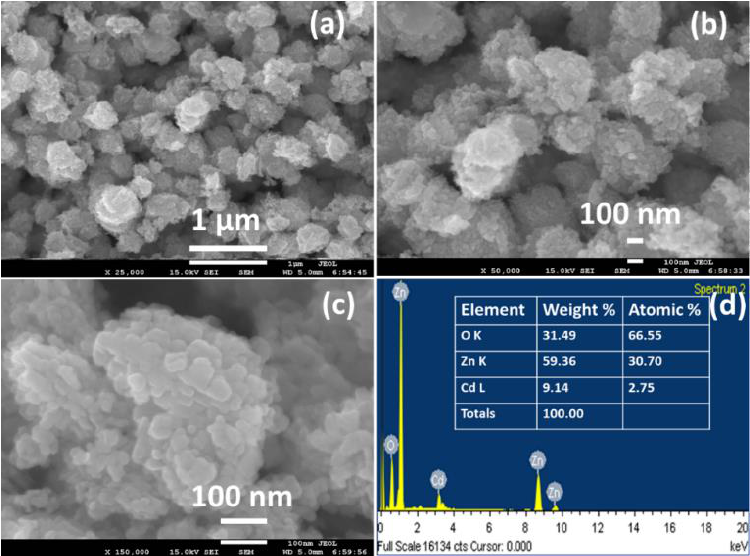
Figure 1. ( a , b ) Low magnification, ( c ) high-magnification FESEM images, and ( d ) EDS spectra (and corresponding elemental composition) of the synthesized CdO-ZnO nanocomposites.